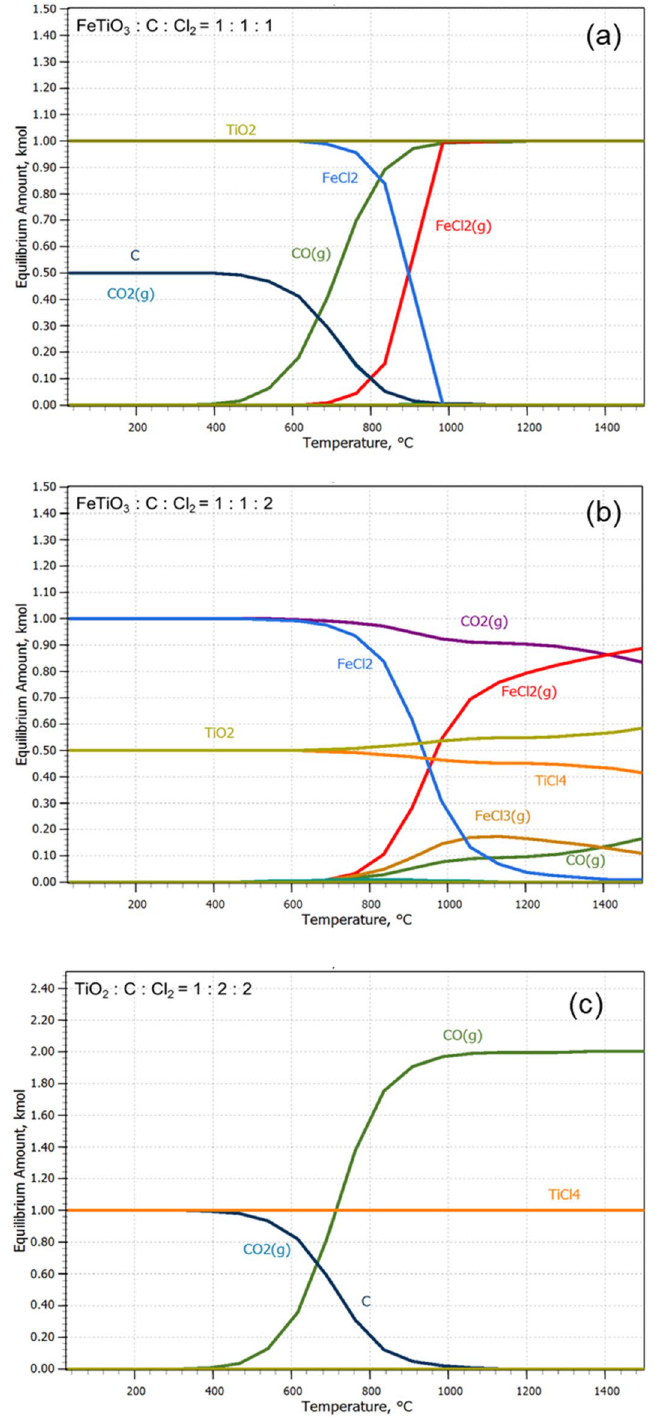
Figure 2. Equilibrium state of ilmenite and rutile ore with varying input amounts of coke and chloride